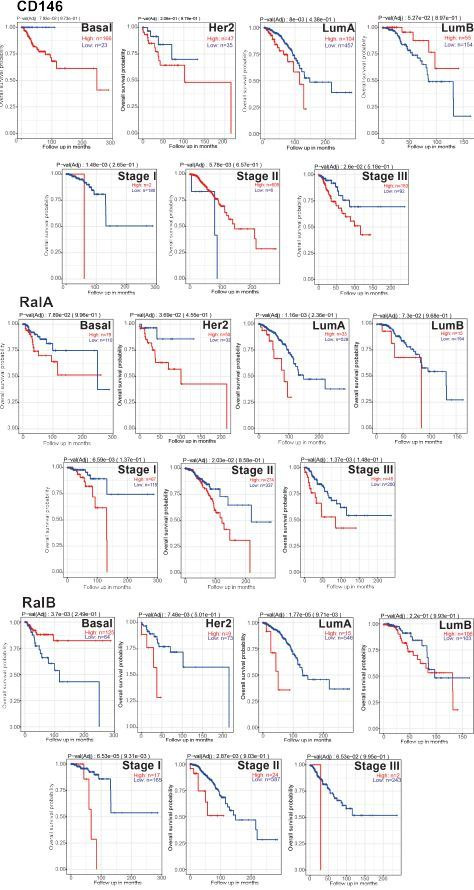
Segmentation of TCGA data.